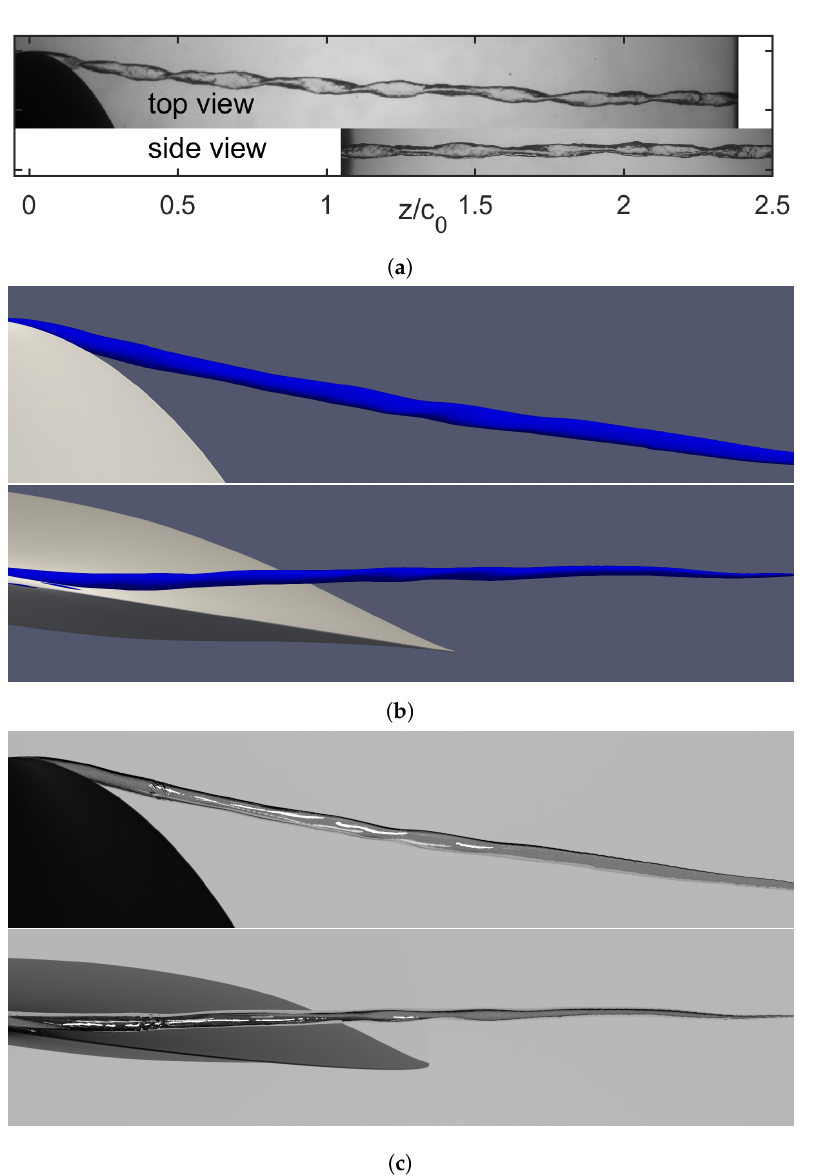
Figure 11. Isolated cavitating vortex in ( a ) experiments (reproduced from [51]), ( b ) ParaView, rasteri- sation, and ( c ) Blender, ray tracing. Free-surface extracted using a vapour volume fraction iso-contour of 0.1. Flow is from left to